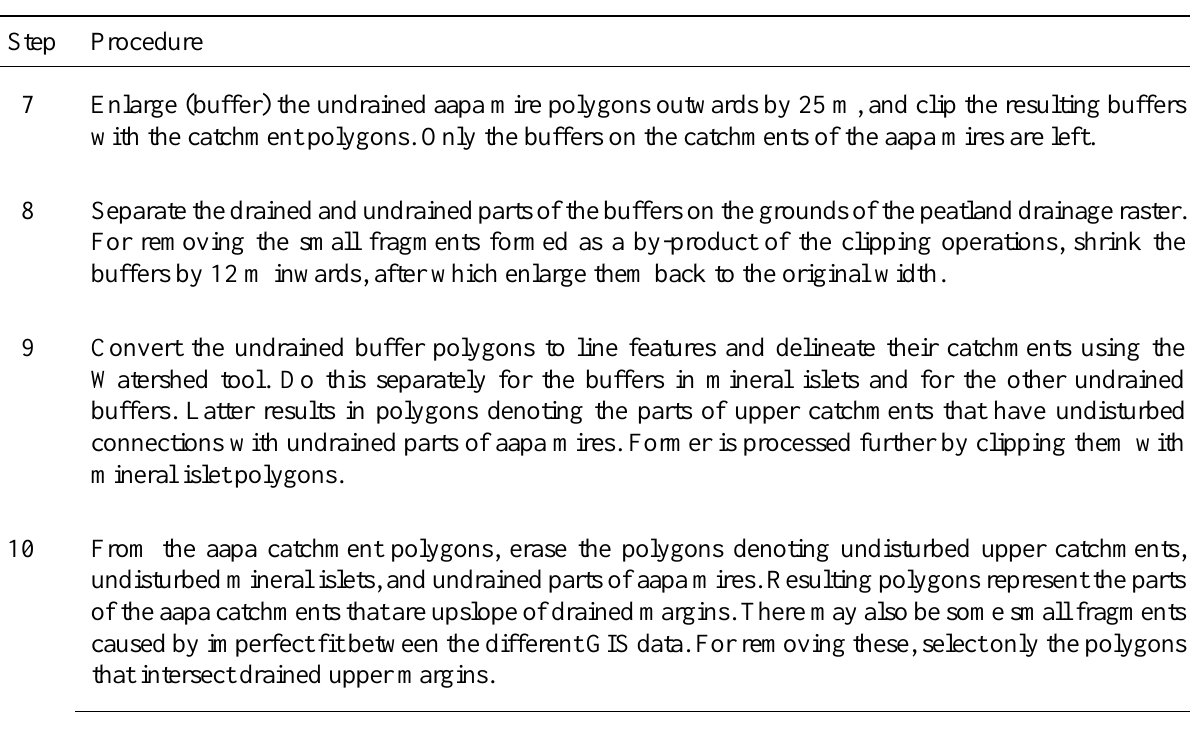
Table 3. Creating data sets for analysing the hydrological naturalness of aapa mires (steps taken after the steps listed in Table